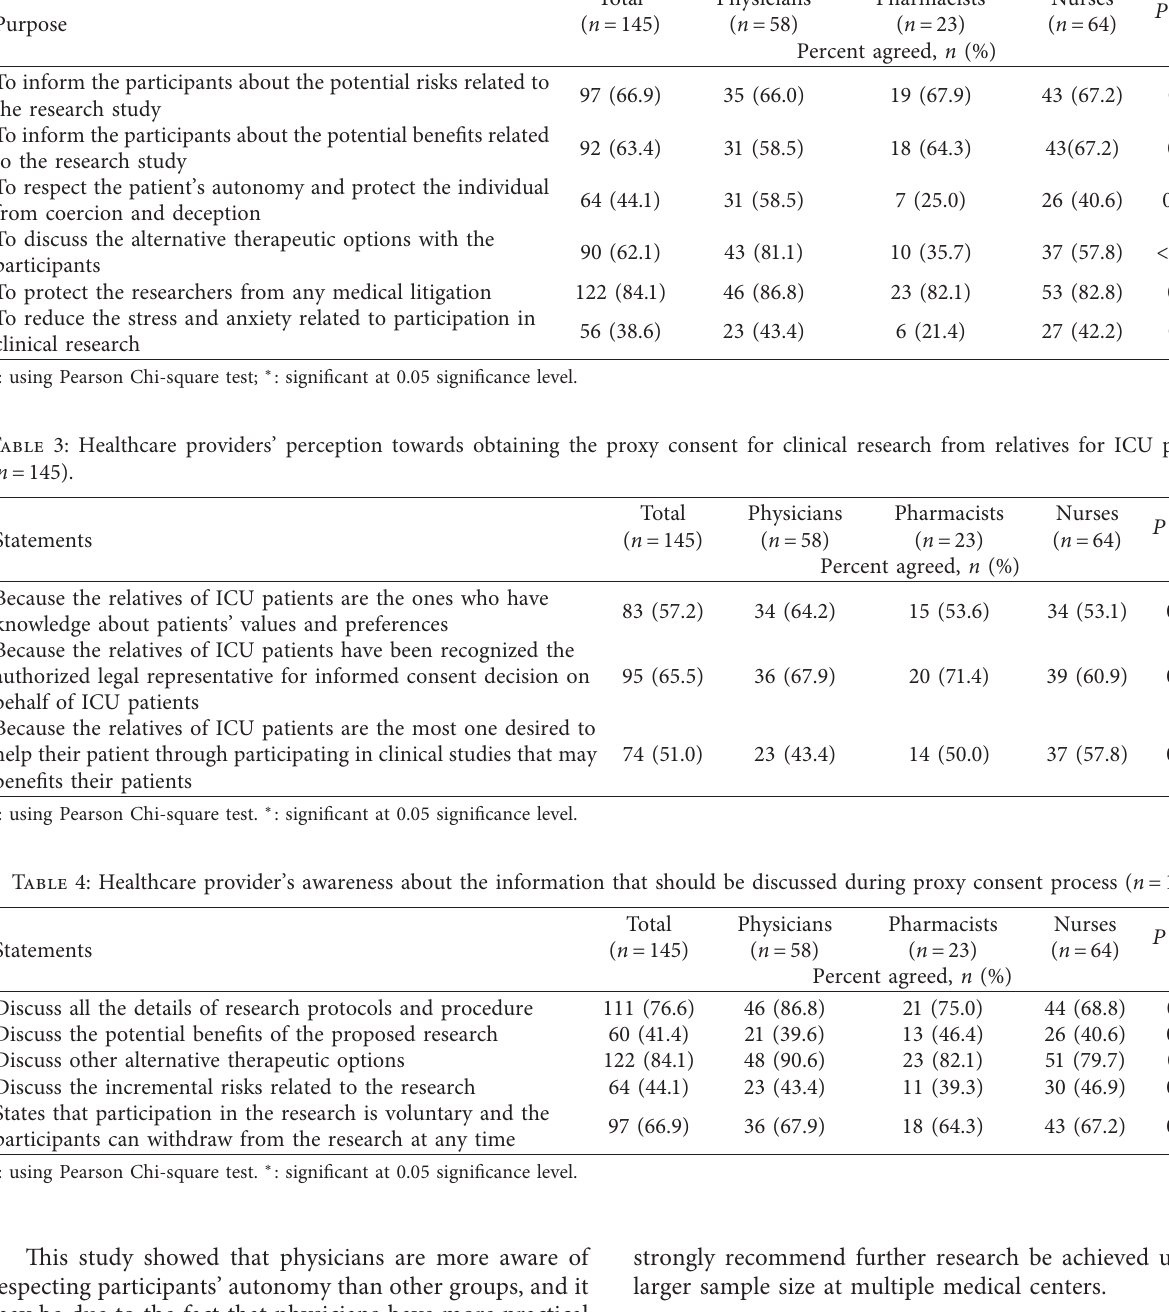
Table 2: Healthcare providers’ awareness about the purposes of informed consent for clinical research in ICU setting ( n � 145).